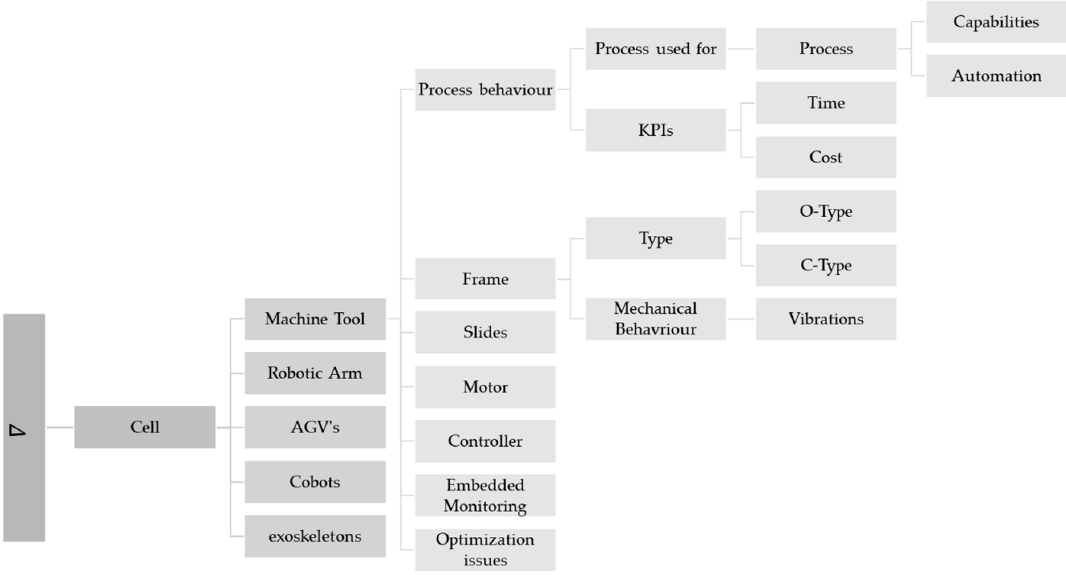
Figure A2. Technologies’ classification: Cell-related